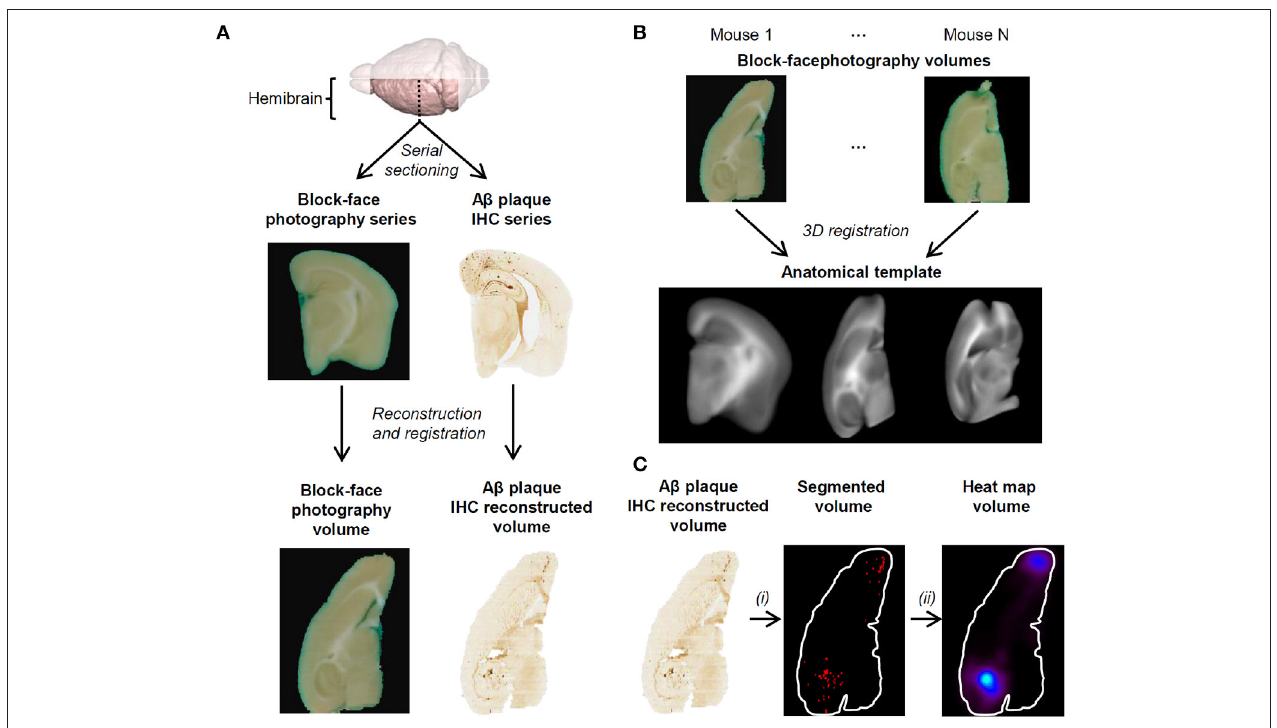
FIGURE 2 | (A) 3D reconstruction of block-face photography and histology volumes. The block-face photography volume for each mouse is generated by stacking each photograph. A β plaque IHC stained coronal section images are stacked and registered to their corresponding block-face photographs. A reconstructed block-face photography volume and its corresponding 3D IHC volume are shown in the axial view. (B) The anatomical template is generated by registering every block-face photography volume onto a common reference. From left to right: coronal view, axial view and sagittal view of the anatomical template. (C) A β plaques are segmented on histology volumes using WRF (i), spatially normalized to the template and continuous-scale quantitative parametric map volumes are derived from the binary volumes (ii). All volumes are shown in the axial view at the same dorsoventral